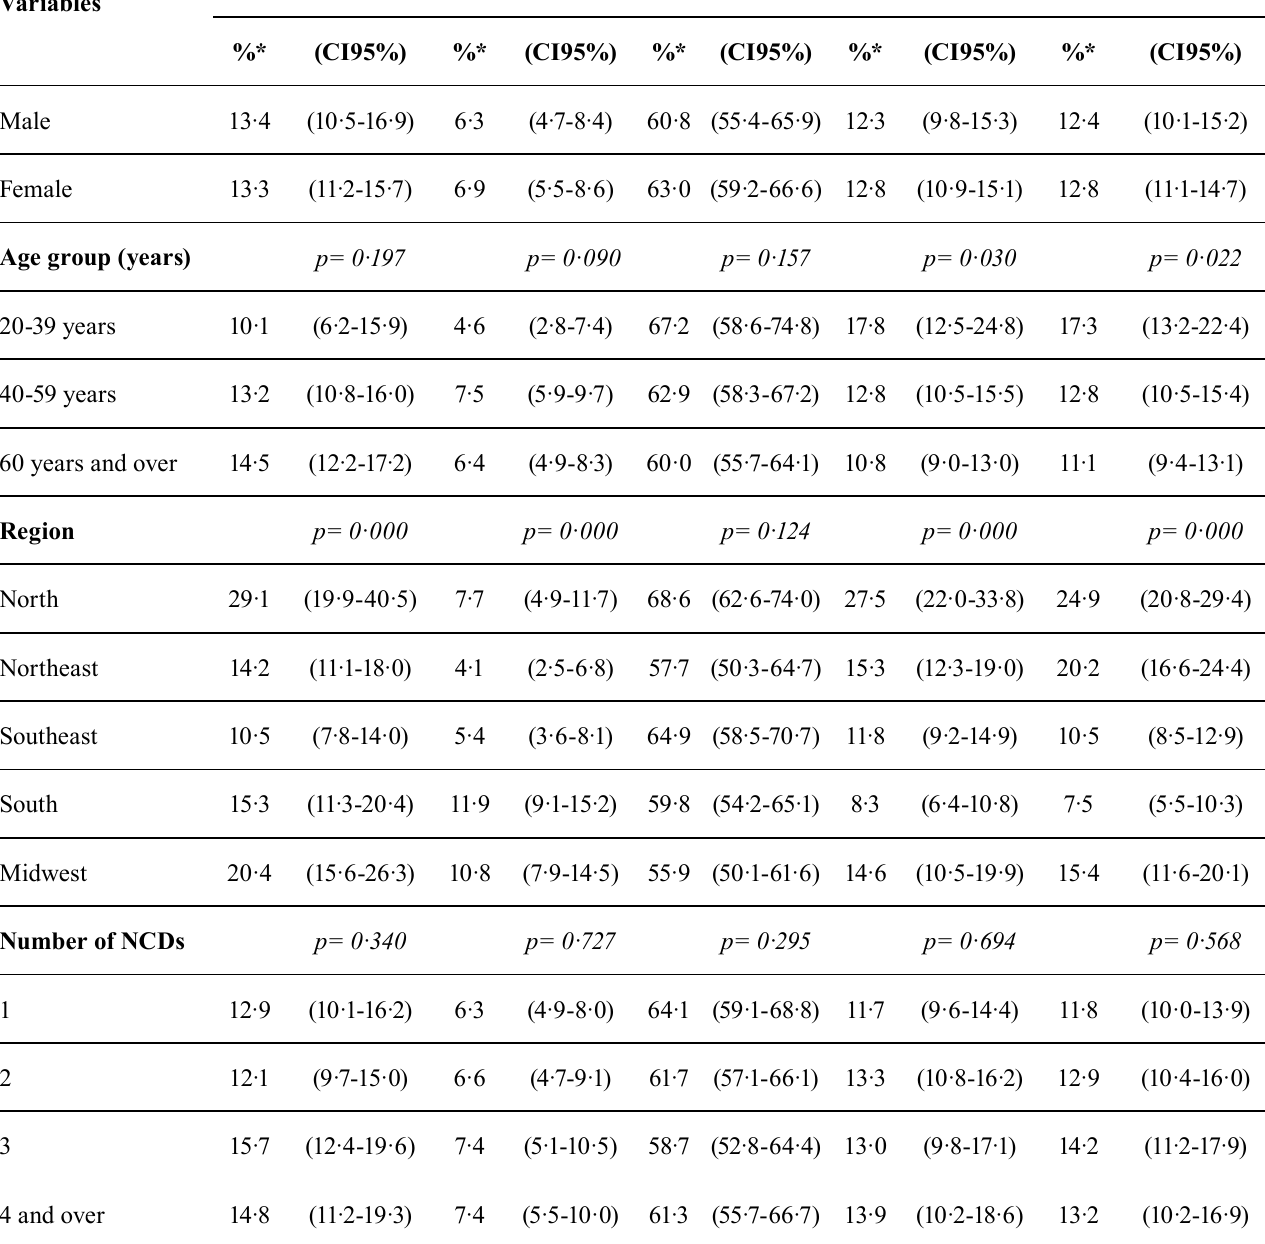
TABLE IV – Difficulties related to the acceptability of SUS pharmacy services by adult and elderly (20 years and over) users of the Unified Health System (SUS) with a reported chronic noncommunicable disease (NCD), indication of medicine treatment and that obtain some of the medicines in use in the SUS, according to demographic, socioeconomic and health variables PNAUM, 2014